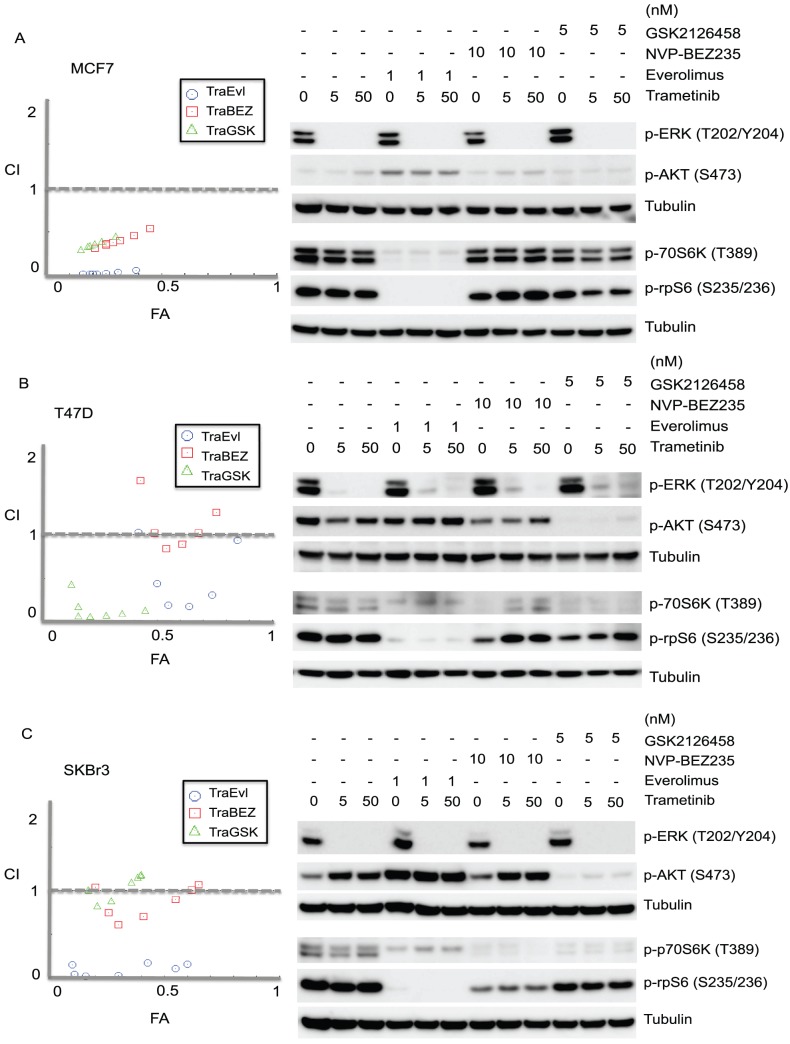
The effects of drug combinations on MCF-7, T47D and SKBr3 cell lines.Left hand panels: Growth inhibitory effects of combinations of trametinib with everolimus (TraEvl), NVP-BEZ235 (TraBEZ) and GSK2126458 (TraGSK) using the Chou-Talalay method. The combination index (CI) theorem of Chou-Talalay defines Synergism: CI<0.9; additivity: 0.90≤CI≤1.1; antagonism: 1.1≤CI≤10 in drug combinations. X axis, FA, the ratio of the fraction affected; y axis, CI, the combination index. Results were from two independent experiments. Right hand panel: Drug combination effect on phosphorylation of ERK, AKT, p70S6K and rpS6 in (A) MCF-7, (B) T47D, (C) SKBr3 cell lines after 24 h as demonstrated by immunoblotting with anti-phospho antibodies. Tubulin is the loading control.